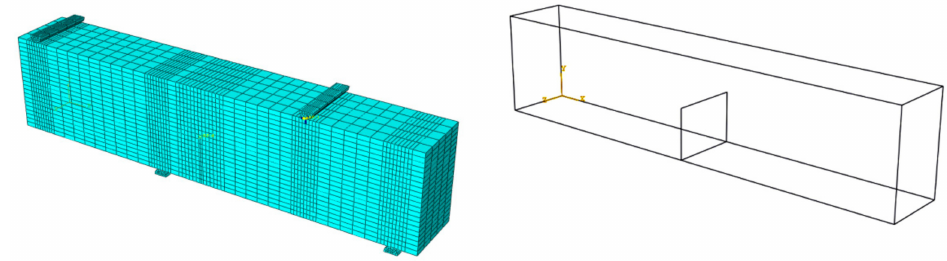
Figure 8. Concrete beam model and initial crack location.